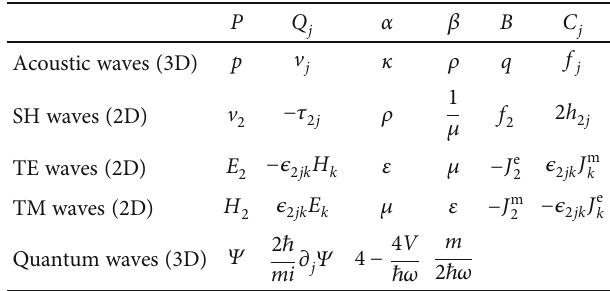
Table 1: Quantities in uni fi ed equations (1) and (2).